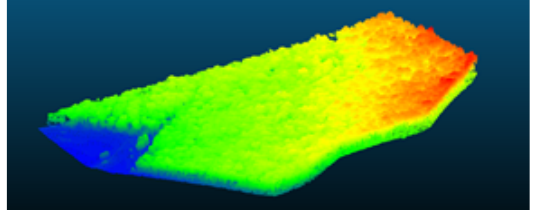
Figure 6: LiDAR pointcloud data. Colour indicates height from 0m to 40m (blue to red).